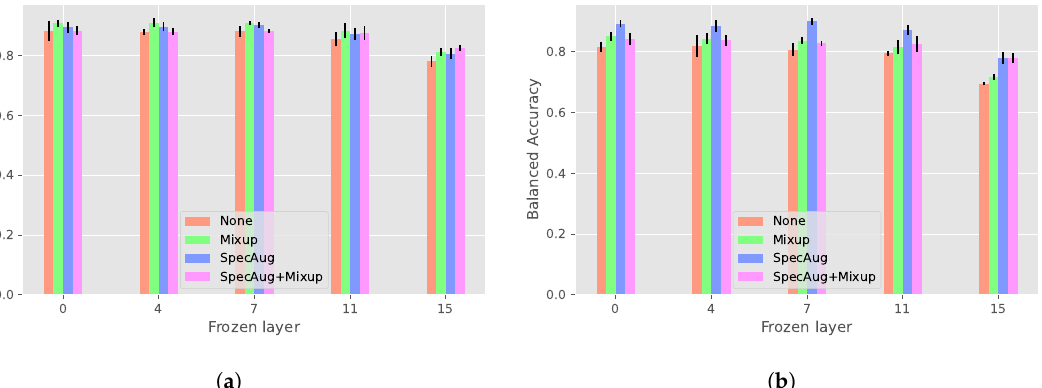
Figure 2. ( a ) Classification performance using deep cascade features with linear SVM, ( b ) End-to-end classification using softmax. For deep cascade features using linear support vector machines (SVM), mixup is slightly better than other methods except for having 15 frozen layers. For end-to-end classification, spectral augmentation (SpecAug) achieves the best performance.